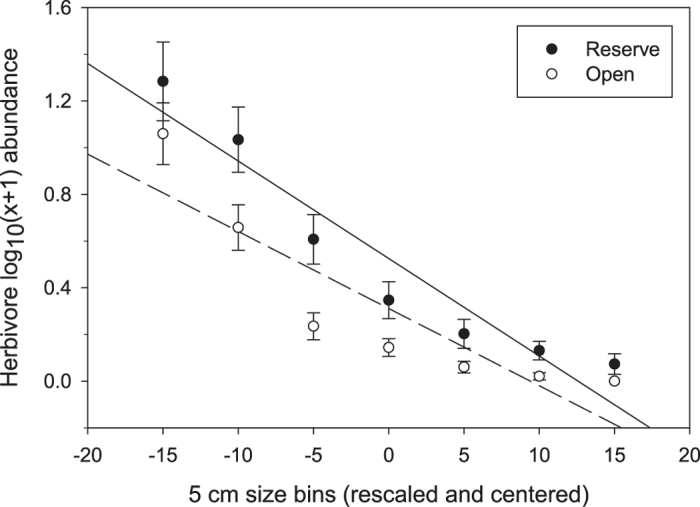
Size spectra analysis of herbivorous fishes.Mean log10(x + 1) transformed abundance by 5 cm size classes for reserve and open areas, rescaled so the midpoint is zero and fitted with ordinary least squares linear regressions (solid line is reserve, dashed line is open area).